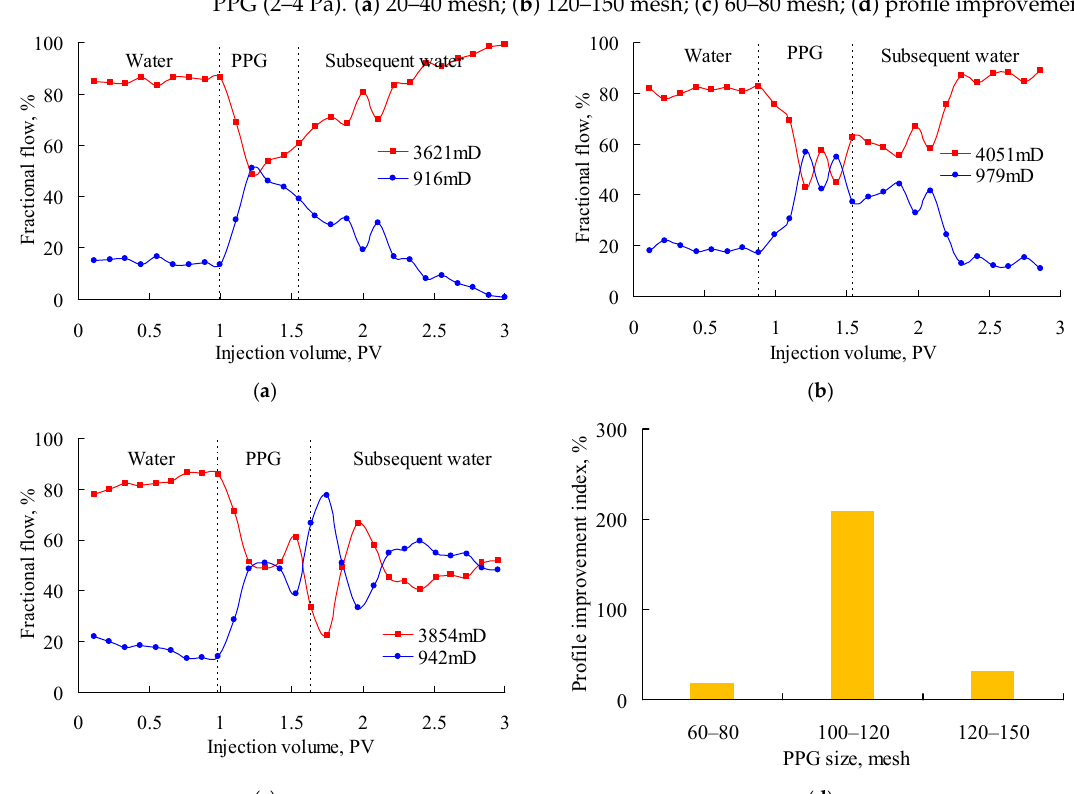
Figure 3. Fractional flow of parallel sand packs with permeability ratio of about 4 after injecting the PPG (2–4 Pa). ( a ) 60–80 mesh; ( b ) 120–150 mesh; ( c ) 100–120 mesh; ( d ) profile improvement index.